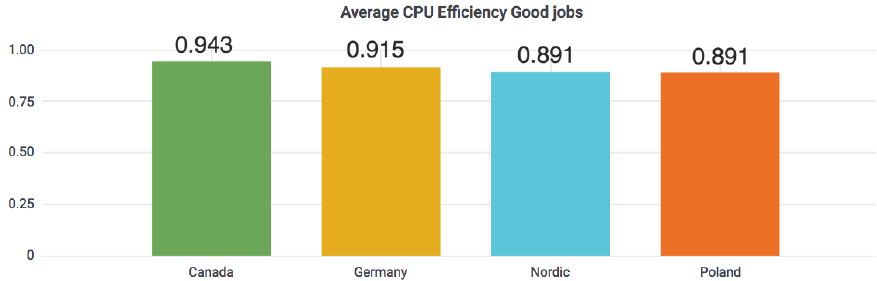
Figure 11: Average CPU e ffi ciency for jobs in 4 di ff erent ARC true-pilot mode sites with local storage (Canada: CA-SFU-T2_UCORE, Germany: FZK-LCG2, DESY-HH_UCORE, Poland: CYFRONET-LCG2_MCORE) and with the Nordic Tier 1 running ARC in the native